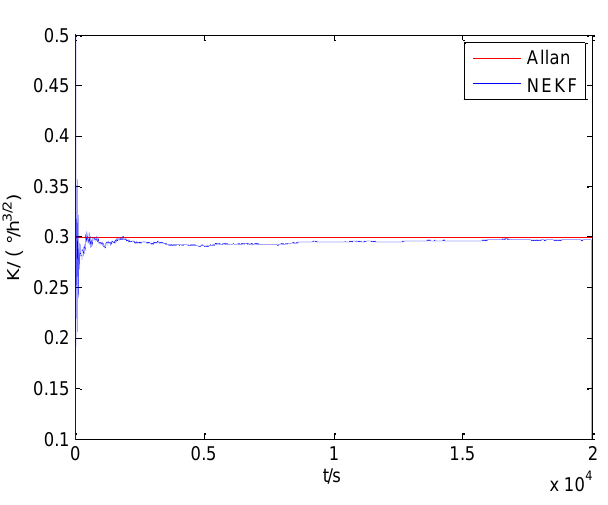
Figure 30. Estimation of B for #2 FOG.